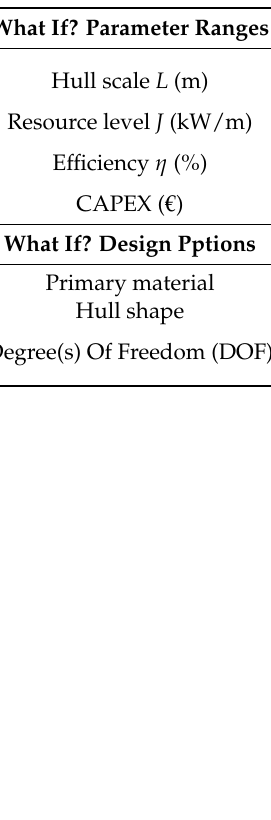
Table 2. Options for the what if? design options: primary material, hull shape and DOF.